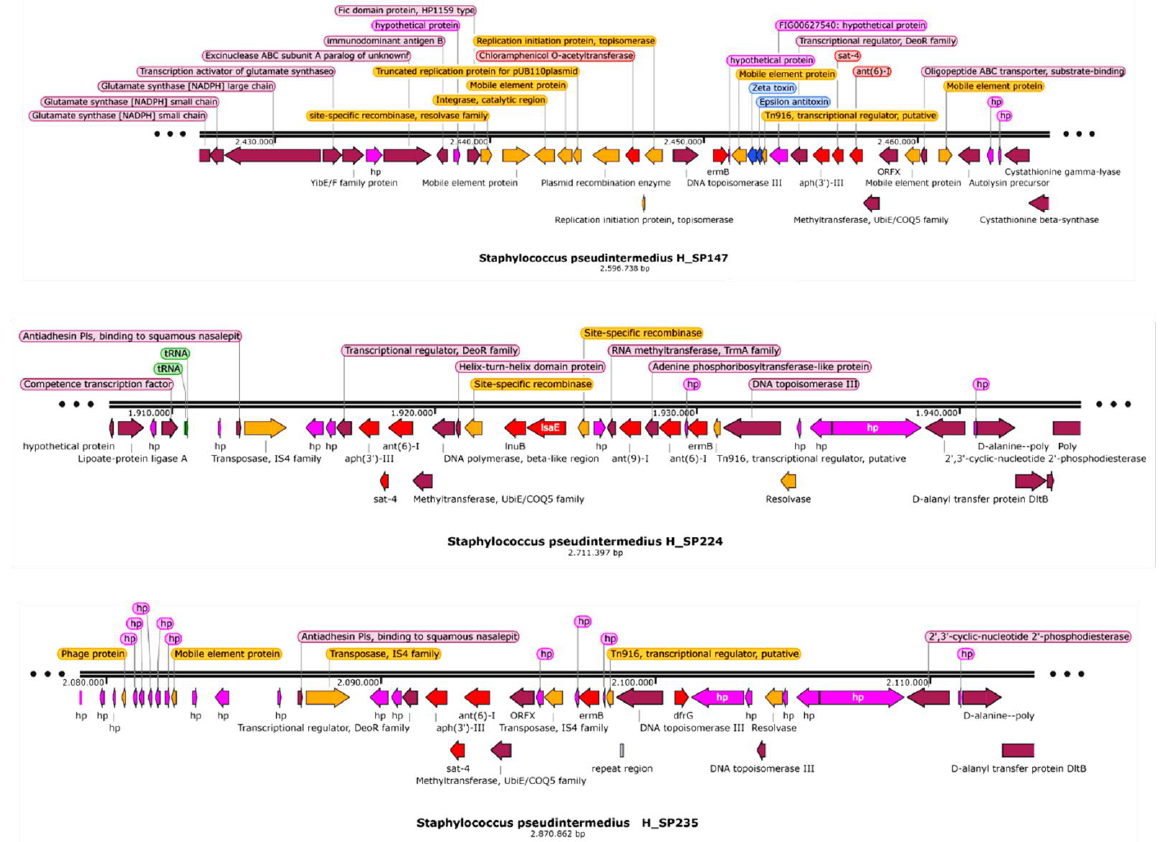
Figure 3. Genomic context of antibiotic resistance genes. In red, the antibiotic resistance genes; in orange, elements related to recombination, mobility, etc.; in pink, hypothetical proteins.